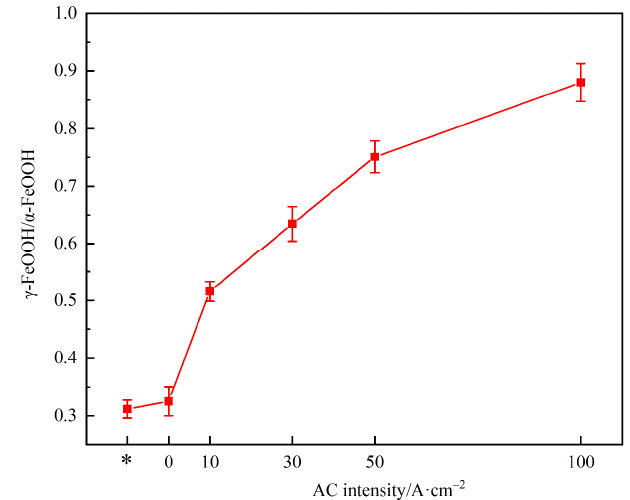
Figure 8. Diagram of the value of γ -FeOOH/ α -FeOOH for carbon steel in the coupled electrodes subjected to interference with different AC intensities in acidic red soil by XRD patterns. * represents the single steel sample without AC interference.